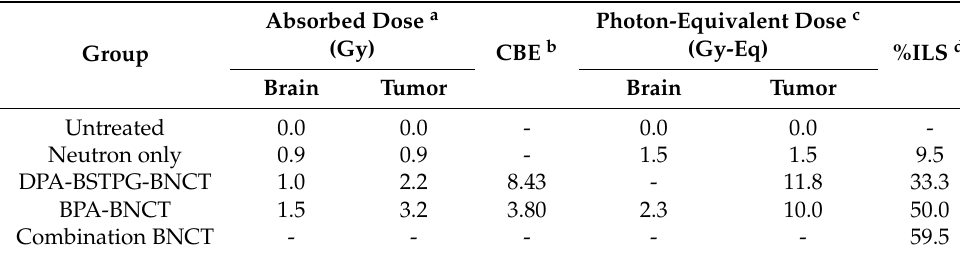
compound biological effectiveness (CBE), and the percentage of increased lifespan (%ILS) for the